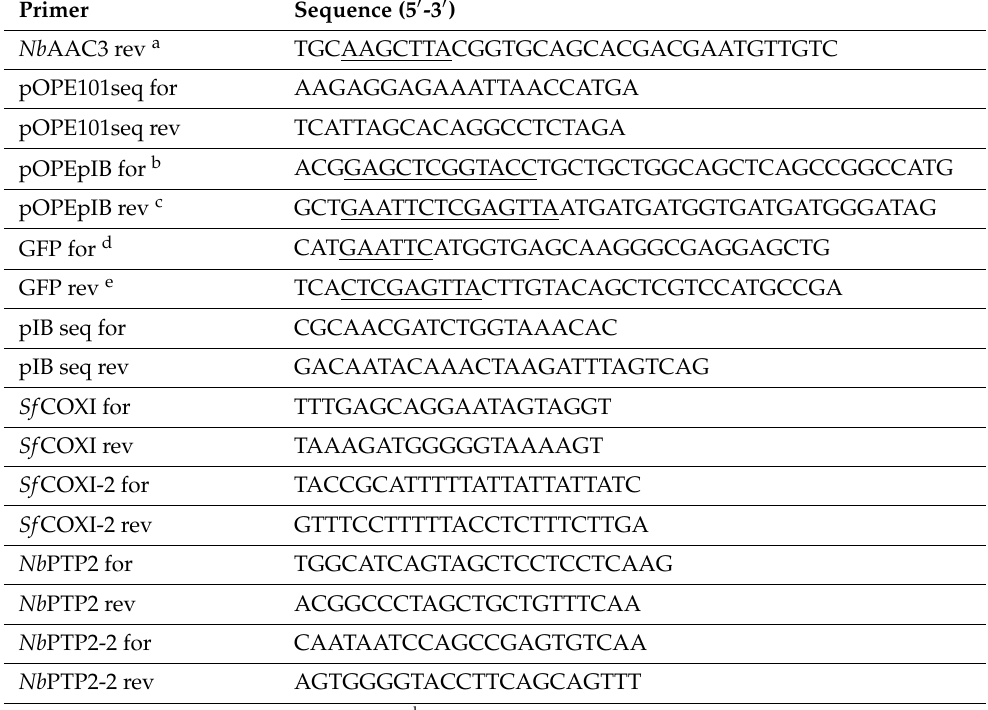
Table 5. List of primers used for PCR amplification and sequencing of N. bombycis , S. frugiperda , scFv genes and their